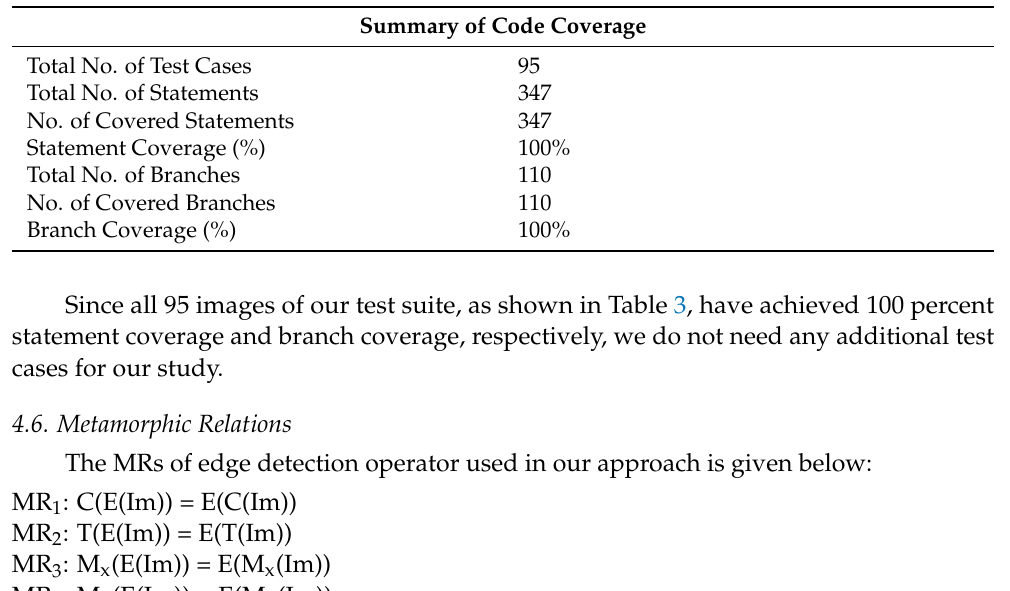
Table 3. Summary of code